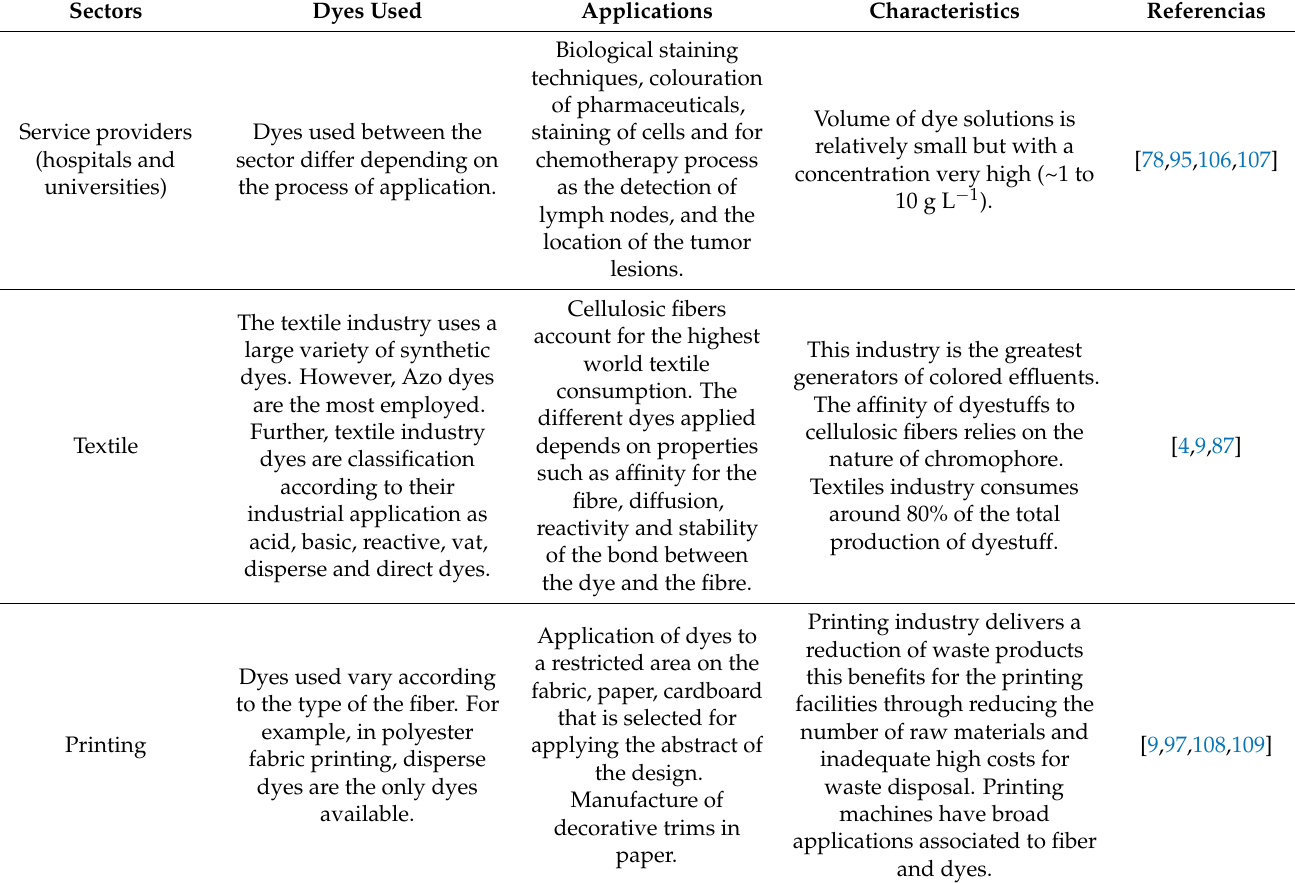
Table 2. Some important aspects of the applications of synthetic dyes in the service sectors and in industry. Sectors Dyes Used Applications